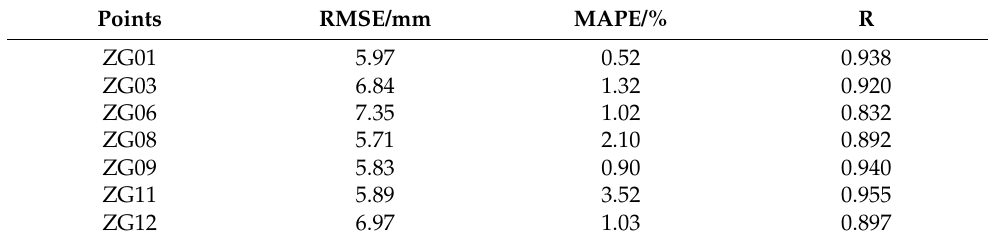
Table 3. The errors of the predicted results of the TCN model.